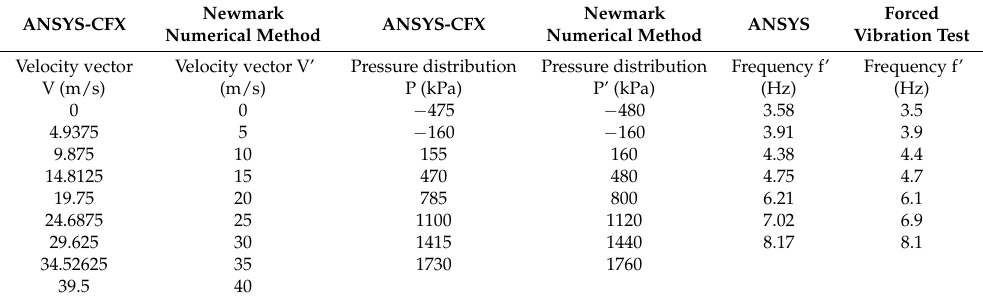
Table 2. The ANSYS-CFX turbine model validation compared with the Newmark numerical method results, and the ANSYS dam model validation compared with Masjed–Soleiman (MS) embankment dam (forced vibration